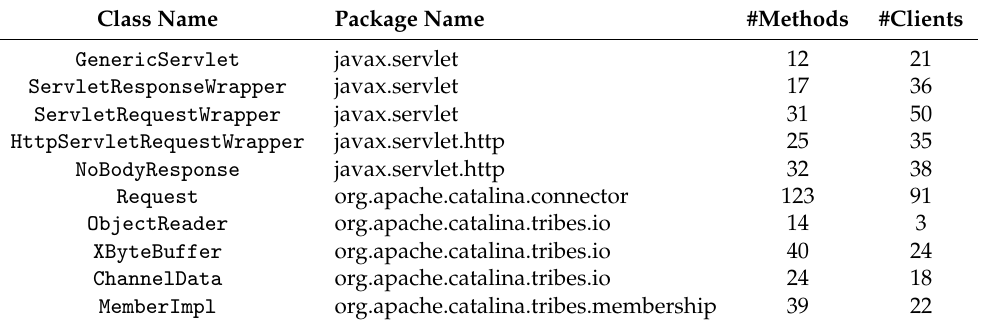
Table 2. The classes selected from Tomcat 6.0.0.